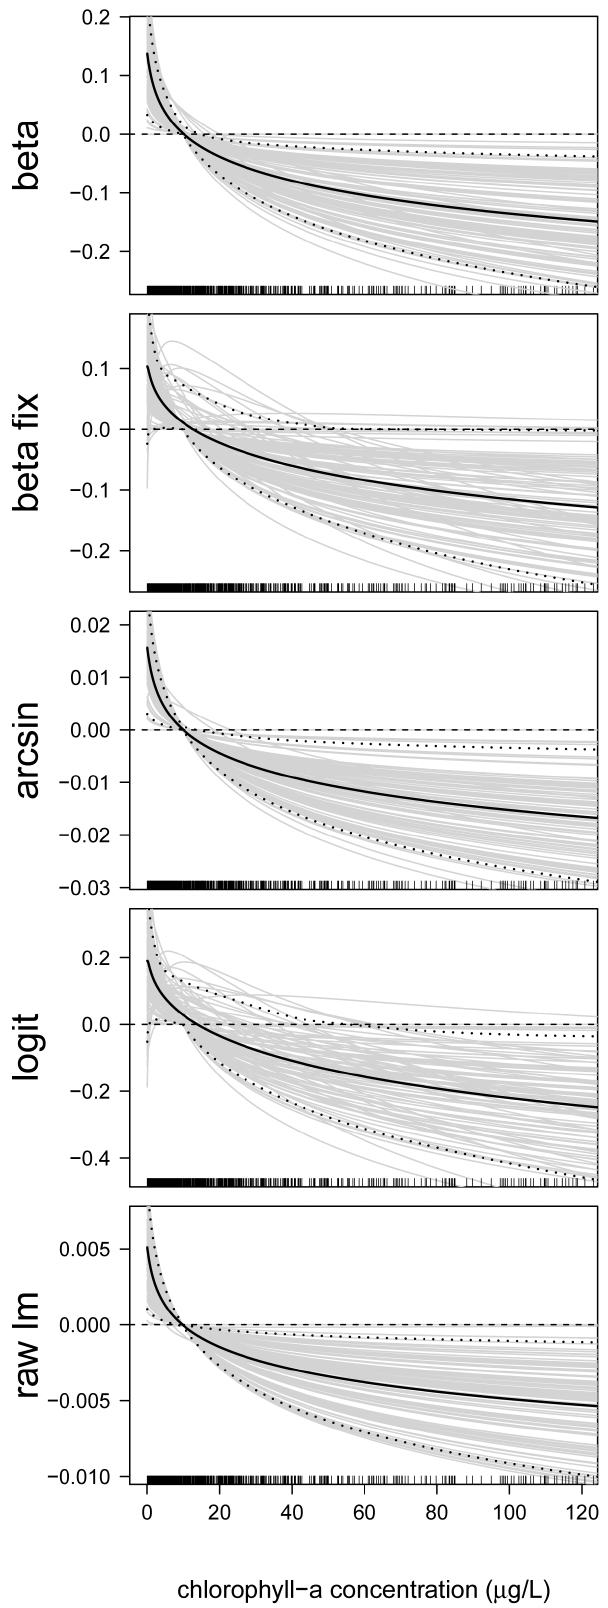
Figure 8. Function estimates for the chlorophyll- a concentra- tion. Analysis of the NLA Data. The five panels contain the function estimates for the chlorophyll- a concentration (computed from 100 bootstrap samples). In case of beta regression, estimates present the effects of the chlorophyll- a concentration on the mean parameter m . Black lines correspond to the mean and the 0.05 and 0.95 quantiles of the function estimates. For reasons of interpretability, the range of the x-axes was restricted to the lower 95% of the sample